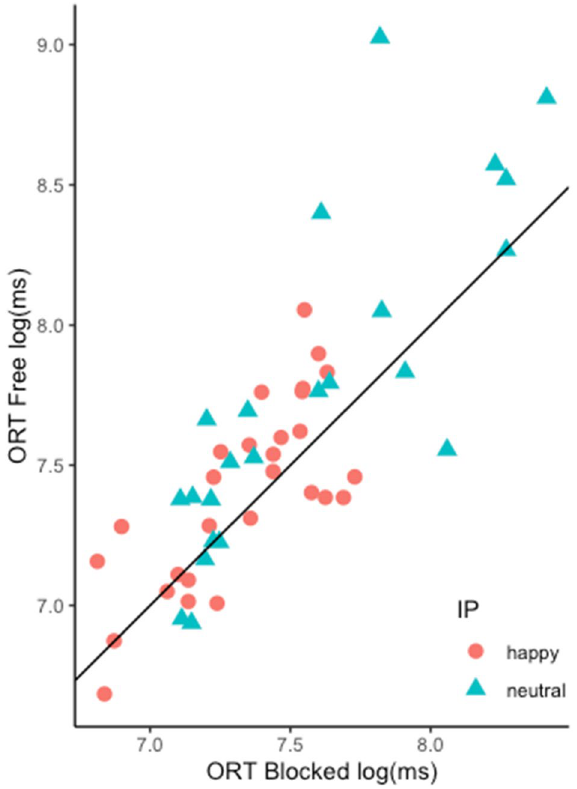
Figure 2. Each point represents a participant’s onset resolution time (ORT) for a specific IP. Mimicry condition is projected on the x and y axes, the black line represents the axes equidistance. The ORT is expressed in